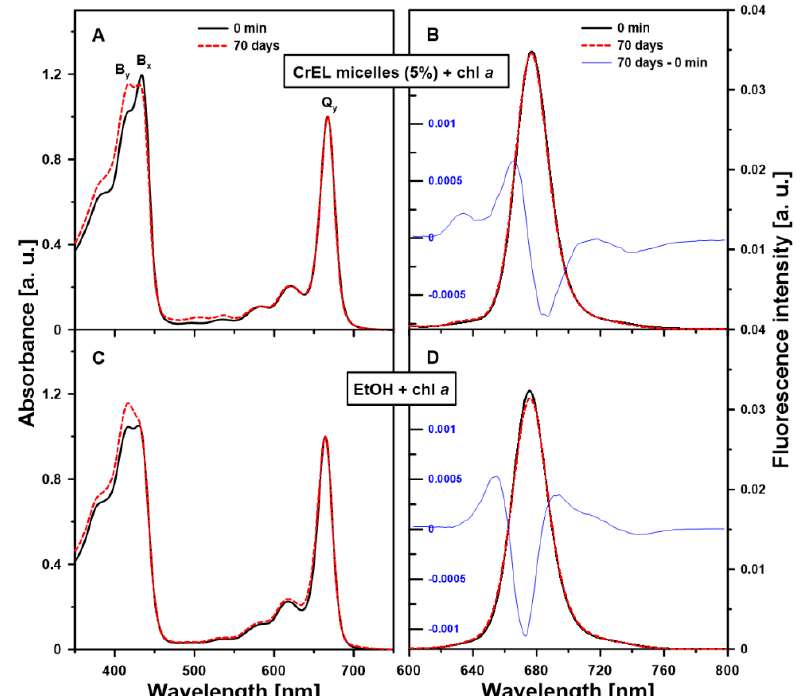
Figure 2. Room temperature electronic absorption and fluorescence emission spectra measured from chl a dissolved in the 5% Cremophor EL nano-emulsion (CrEL micelles (5%) + chl a ; panels ( A , B )) or 96% ethanol (EtOH + chla a ; panels ( C , D )). The molar concentration of chl a in the samples was 10 − 5 M. The spectra were registered directly after the sample preparation (0 min, black solid line) and after 70 days of storage of the samples in the dark (70 days, red dashed line). The experiment was repeated three times (biological replicates). The representative results are included in the figure. The absorbance spectra were normalized in the Q y band and the fluorescence emission spectra were normalized to get the same area beneath each spectrum. In B , D panels, the difference spectra were added (70 days–0 min, blue thin line). The emission spectra were registered with the excitation at 434 nm.